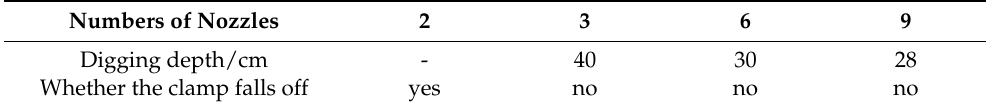
Table 6. Relationship between the number of nozzles and the flushing depth.